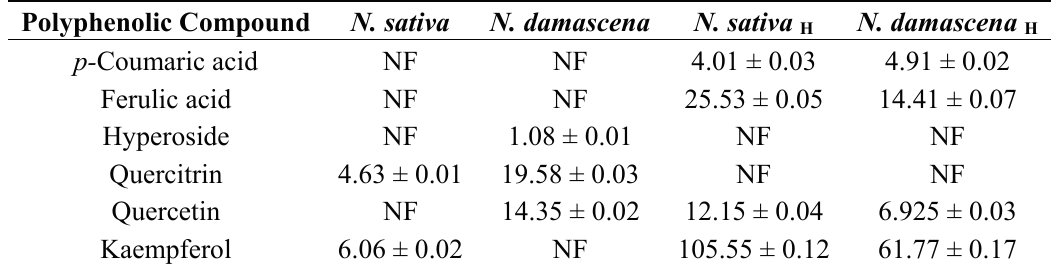
Table 1. The polyphenolic compounds content in N. sativa and N. damascena seeds ( μ g·g − 1 dw plant material).